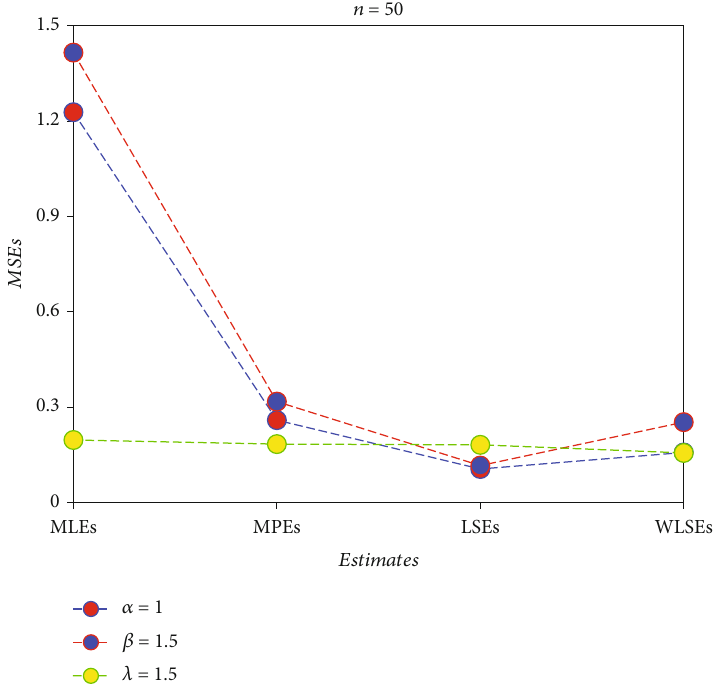
Figure 9: MSEs using n = 50 : α = 1 , β = 1 : 5 , and λ = 1 : 5